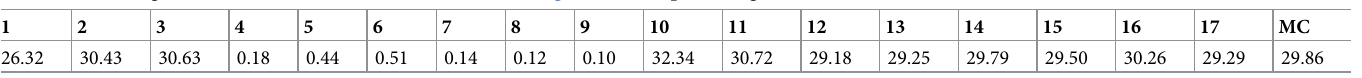
Table 6. Processing time (seconds) for the five fetal heartbeats in Fig 2, for the 18 processing chains obtained from the